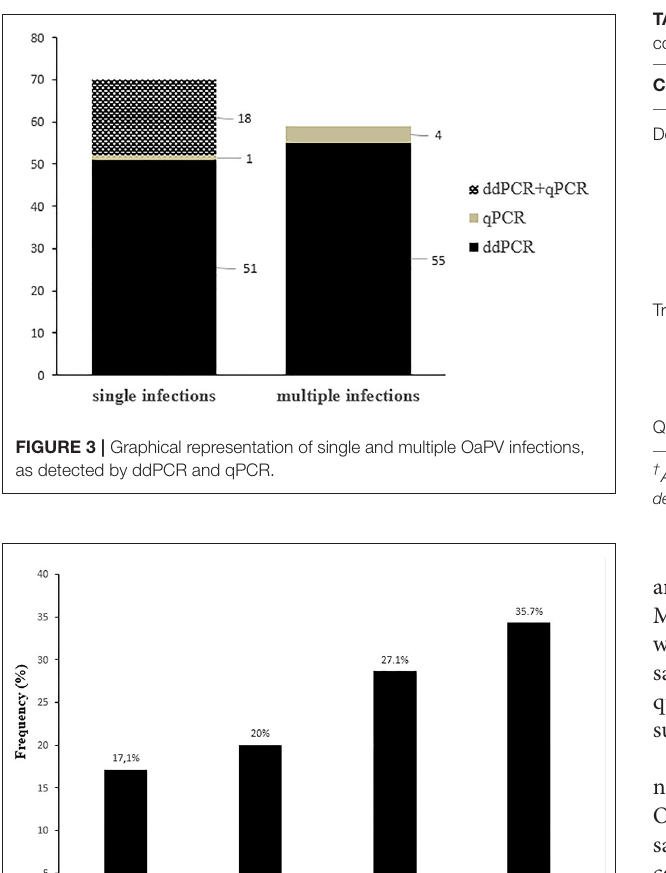
single infections ( ∼ 17.1%) and OaPV2 DNA in 14 (20%). OaPV3 and OaPV4 were responsible for 19 ( ∼ 27.1%) and 25 ( ∼ 35.7%)